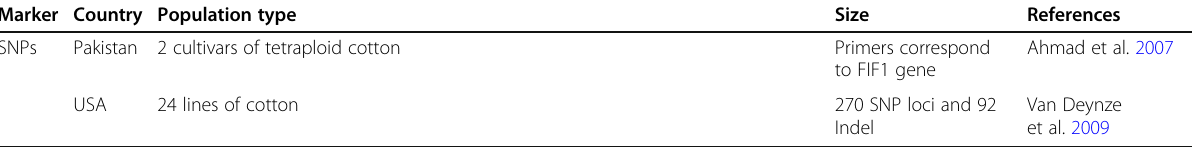
Table 4 An overview of genetic diversity studies in cotton using molecular markers (Continued) Marker Country Population